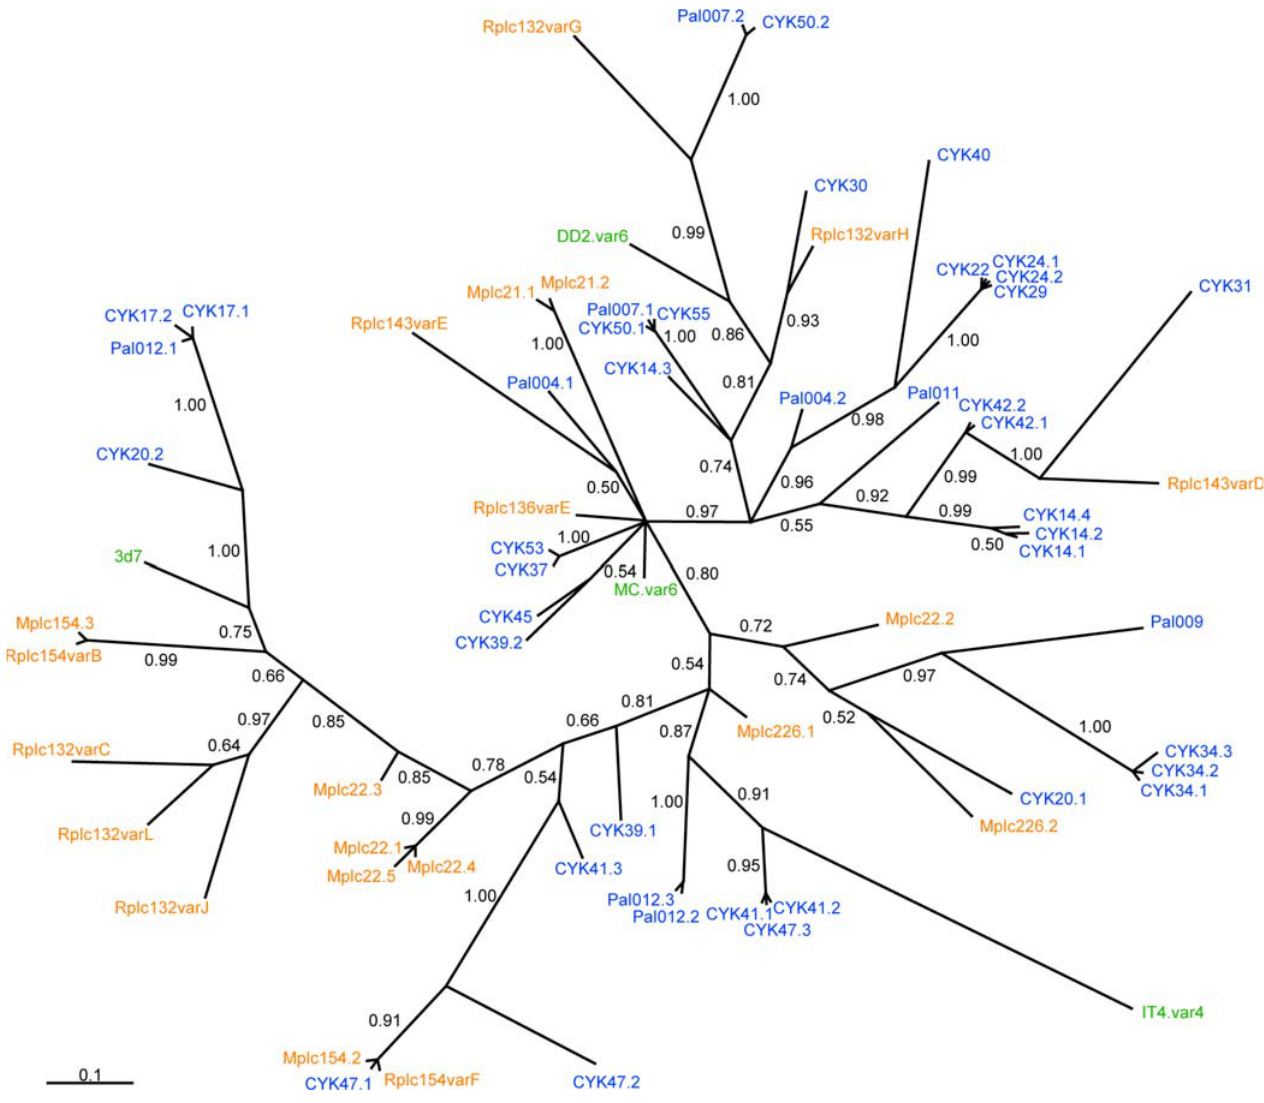
Figure 2. Phylogenetic Relationship between Different VAR2CSA DBL3X Sequences Bayesian inference tree of 43 placental cDNA sequences from Senegal (blue), 21 Malawian sequences (orange), and database sequences from four isolates (green) of different geographic origin. The posterior probability of the clades is shown at the